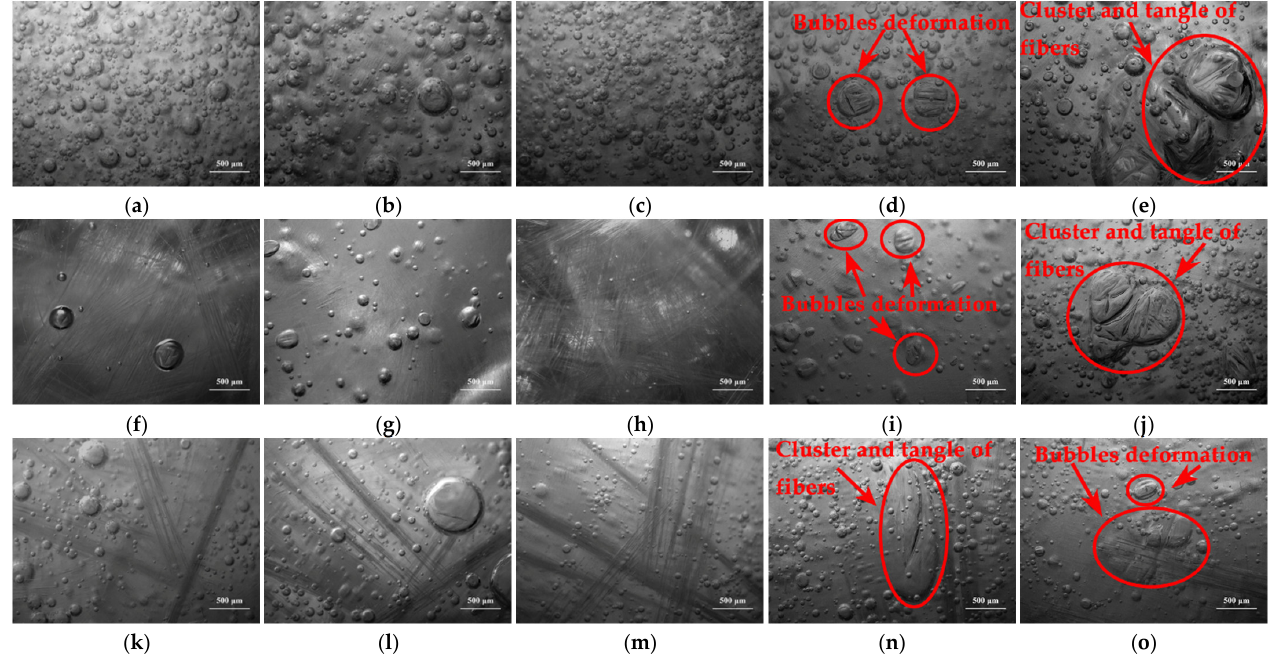
Figure 2. Micrographs of distributions of 15.00 phr of chopped glass fibers in resin glue ( a ) at a length of 9.0 mm, ( b ) at a length of 12.0 mm, ( c ) at a length of 15.0 mm, ( d ) at a length of 18.0 mm, ( e ) at a length of 21.0 mm got from type ECR13-300D-608, ( f ) at a length of 9.0 mm, ( g ) at a length of 12.0 mm, ( h ) at a length of 15.0 mm, ( i ) at a length of 18.0 mm, ( j ) at a length of 21.0 mm got from type ER2400-T628, ( k ) at a length of 9.0 mm, ( l ) at a length of 12.0 mm, ( m ) at a length of 15.0 mm, ( n ) at a length of 18.0 mm, ( o ) at a length of 21.0 mm got from type ER4800-T718.